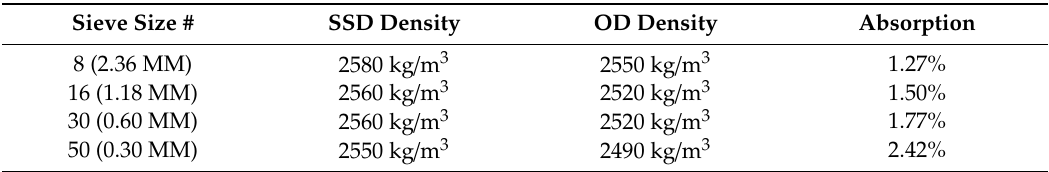
Table 2. Mix design of NIST reference material replicate.